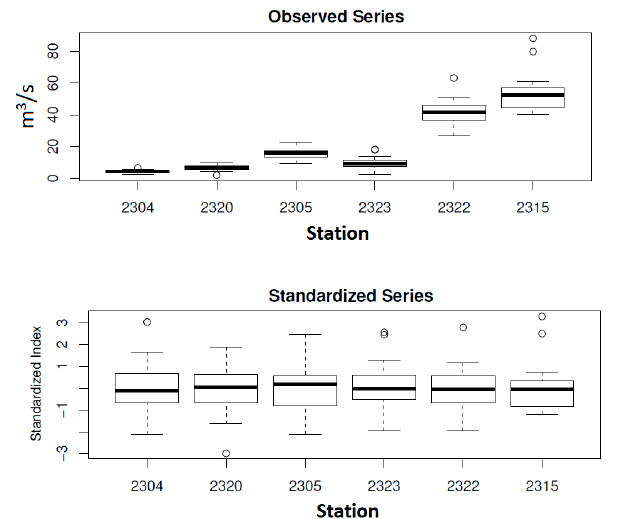
Figure 3. Box-plots showing the distributional features of the observed time series ( top panel ), and of the standardized time series ( bottom panel )—see text.